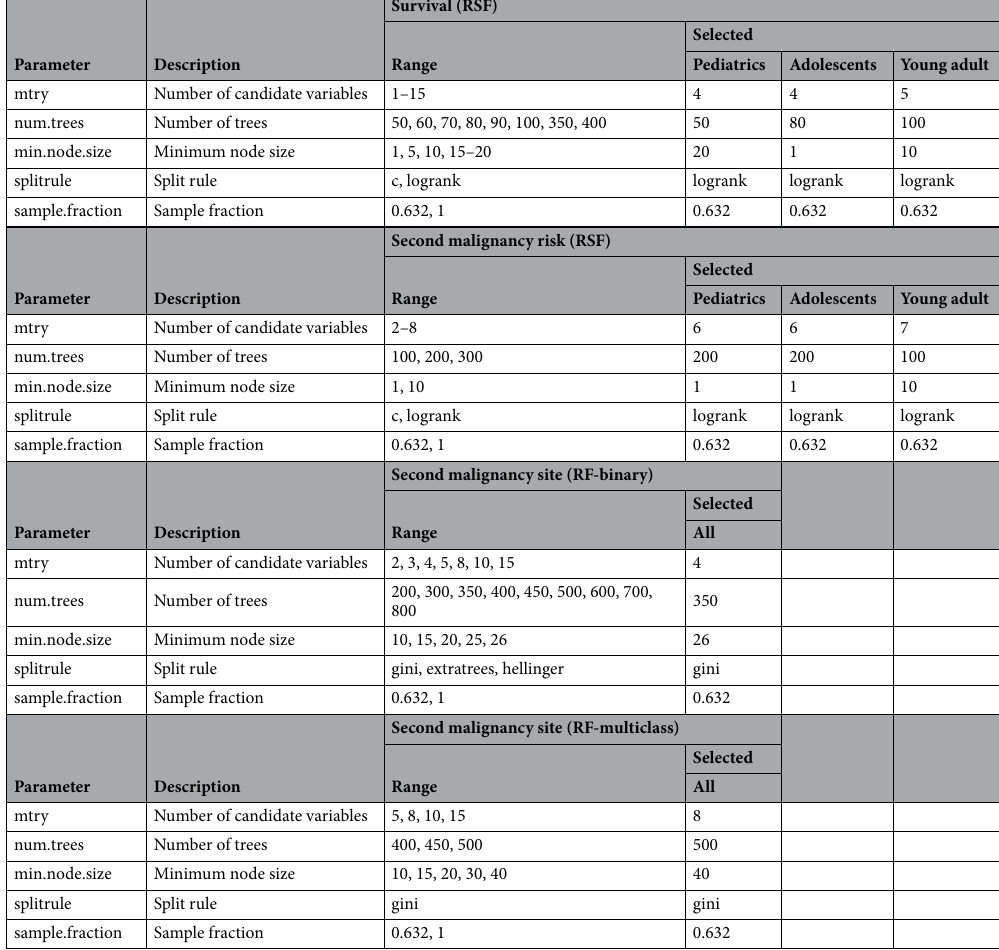
Table 2. Hyperparameters for RSF and